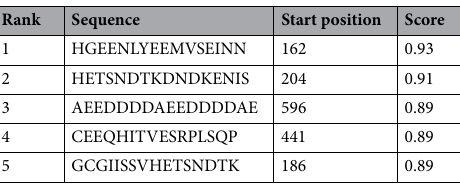
Table 1. List of the five B-cell epitopes from PfGARP protein by ABCpred Server.